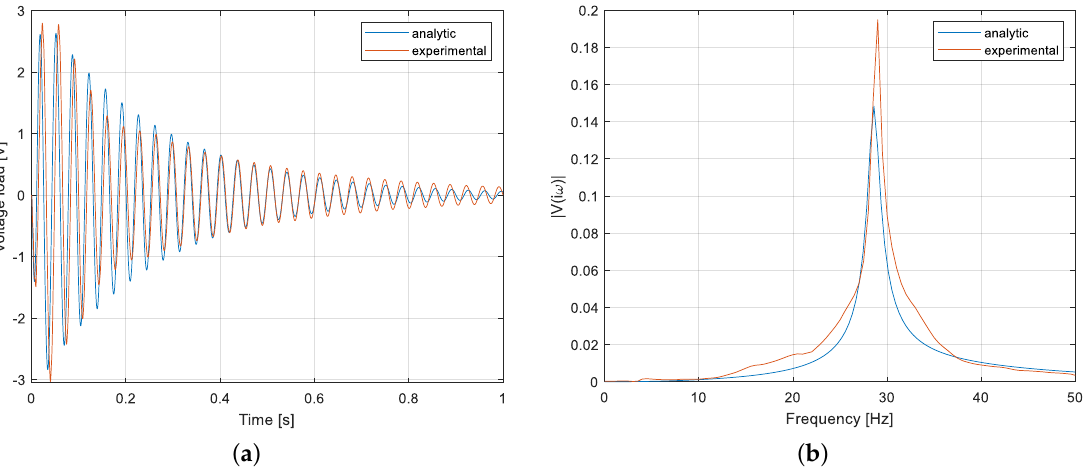
Figure 18. Comparison between the experimental (red) and simulated (blue) harvester voltage in the time ( a ) and frequency ( b ) domain for a drop impacting on a spoon full of